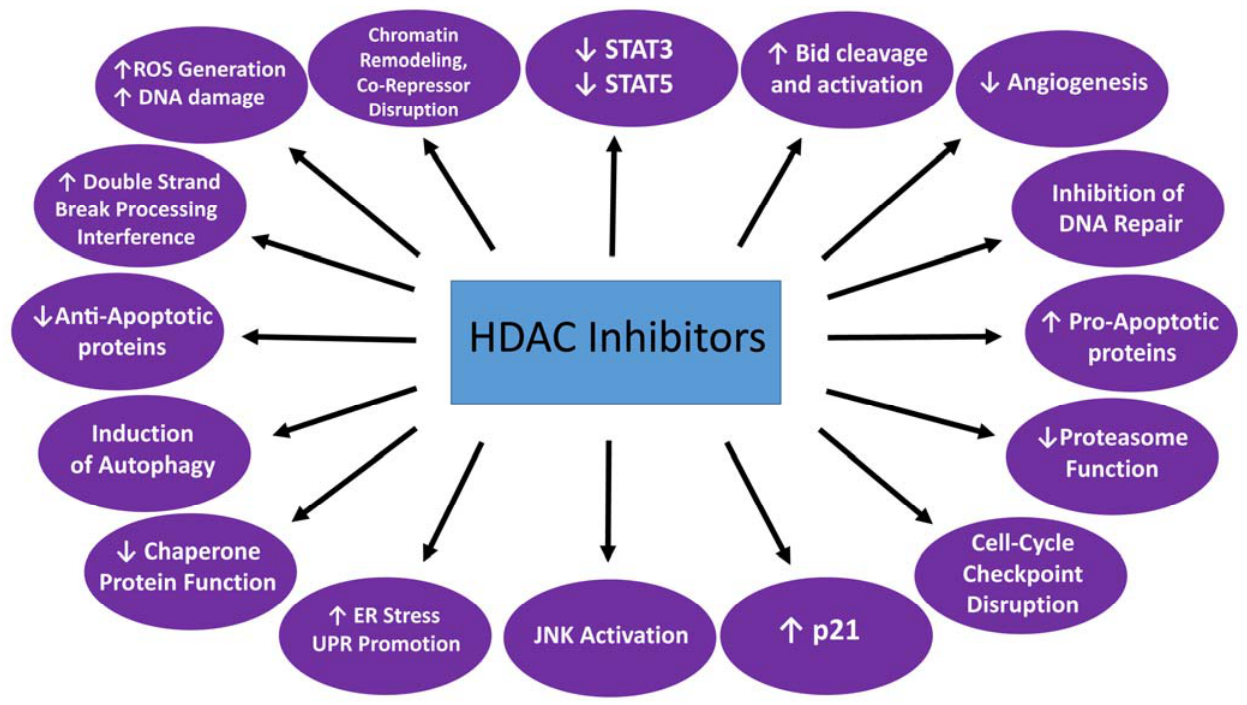
Figure 1. Mechanisms of HDACI lethality. Reproduced, with permission, from